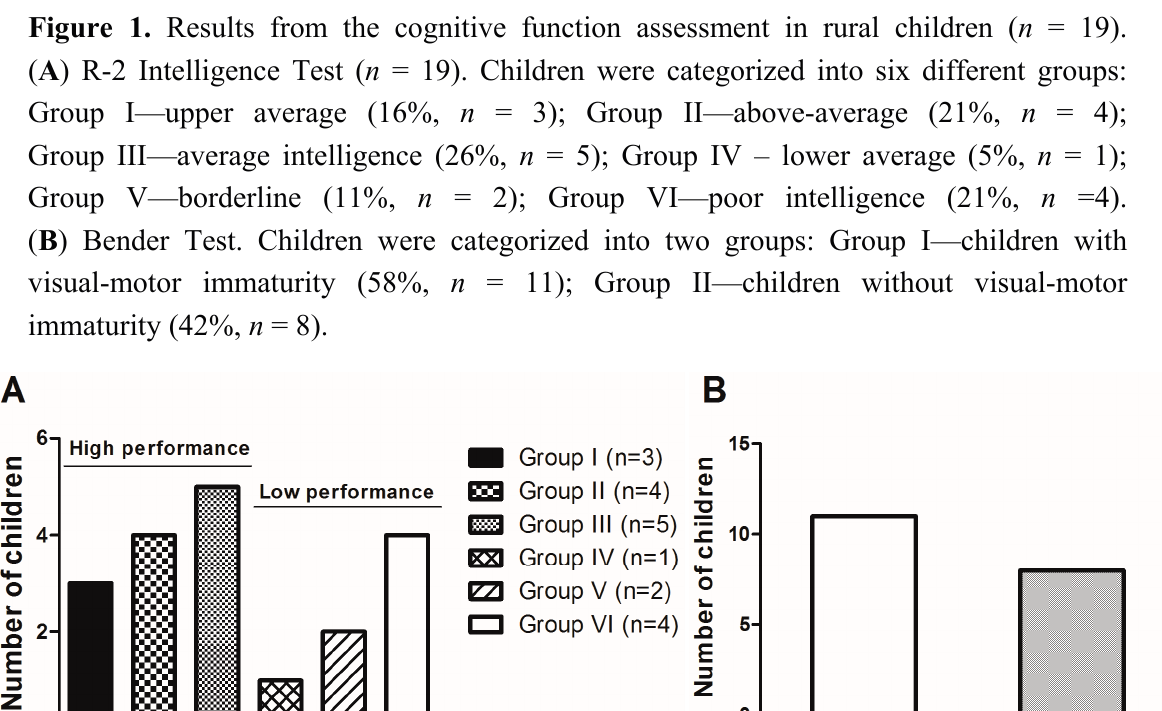
Figure 1. Results from the cognitive function assessment in rural children ( n =